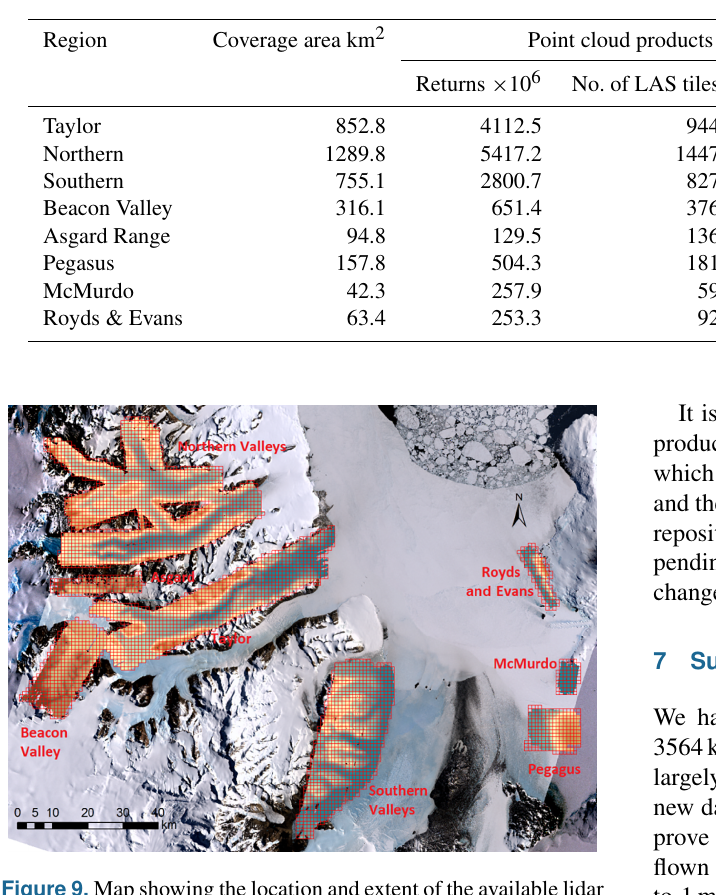
Figure 9. Map showing the location and extent of the available lidar data products. Base map is the Landsat Image Mosaic of Antarctica (Bindschadler et al.,